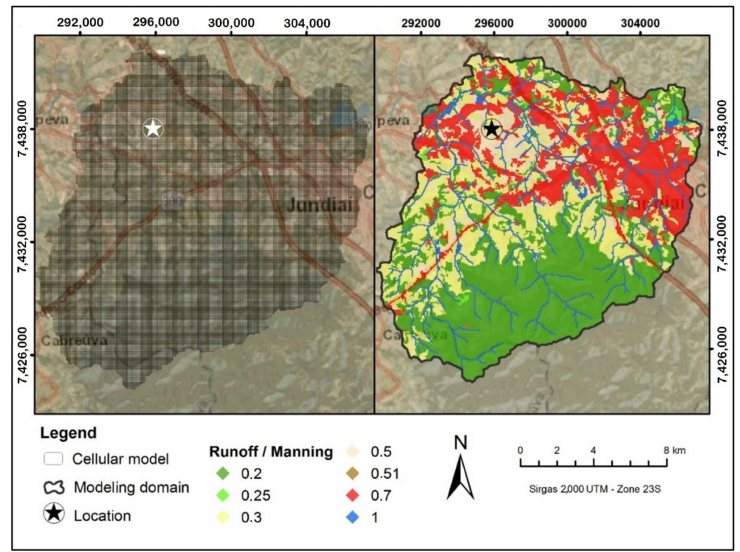
Figure 9. Model domain for industrial park and runoff coefficient for the model domain, representing the land cover of the area.